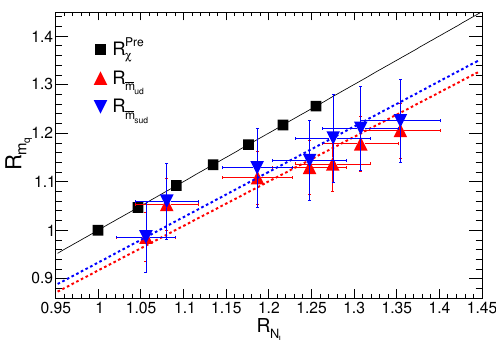
Figure 21 . Comparisons of R m diction R Pre . The black, red, and blue lines indicate the (cid:12)tting results.